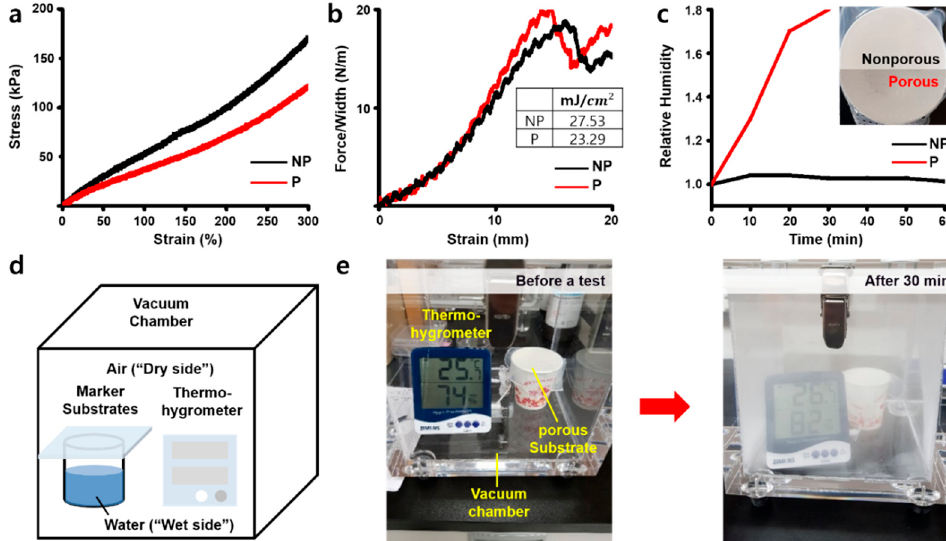
Figure 4. Mechanical characterizations of the skin ‐ like porous patch. ( a ) The stress–strain curve of both nonporous (black) and porous substrate (red). ( b ) The stress–strain curve of adhesives on both nonporous (black) and porous substrate (red). Inset: the adhesion energy of them. ( c ) The relative humidity of both nonporous (black) and porous substrate (red). Inset: the image of nonporous (top) and porous substrate (bottom). ( d ) The structure of water vapor transmission rate test chamber inspired by ASTM F1249. ( e ) Before and after the water vapor transmission rate test of the porous substrate.